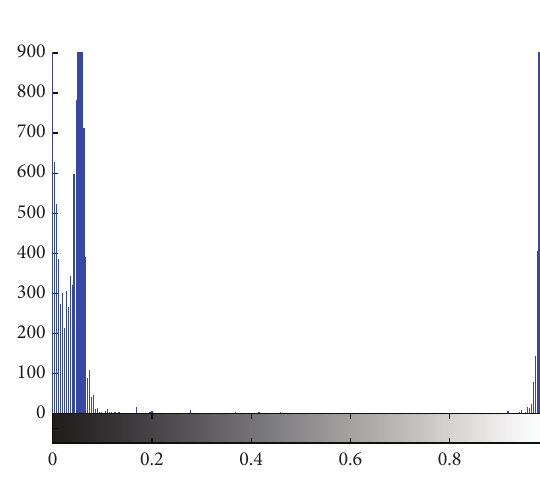
Figure 6: Hue histogram of